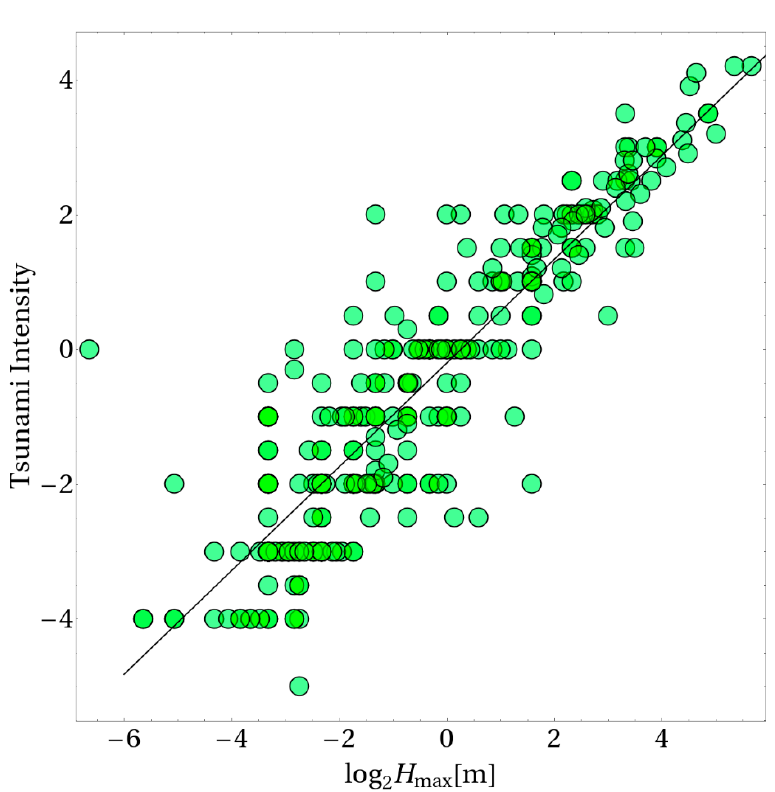
Figure 3. The relationship between the intensity of a tsunami on the Soloviev–Imamura scale and the maximum height of the water rise (maximum runup) in accordance with the DB1 data (235 events—circles). The black line is a regression dependence constructed with the least squares method. Pearson’s correlation coefficient is ≈ 0.901.